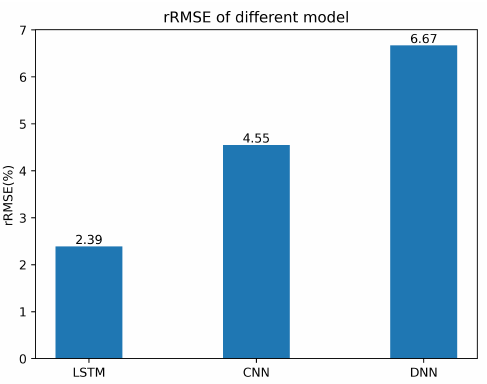
Figure 6. Air quality index prediction errors of different neural network models.